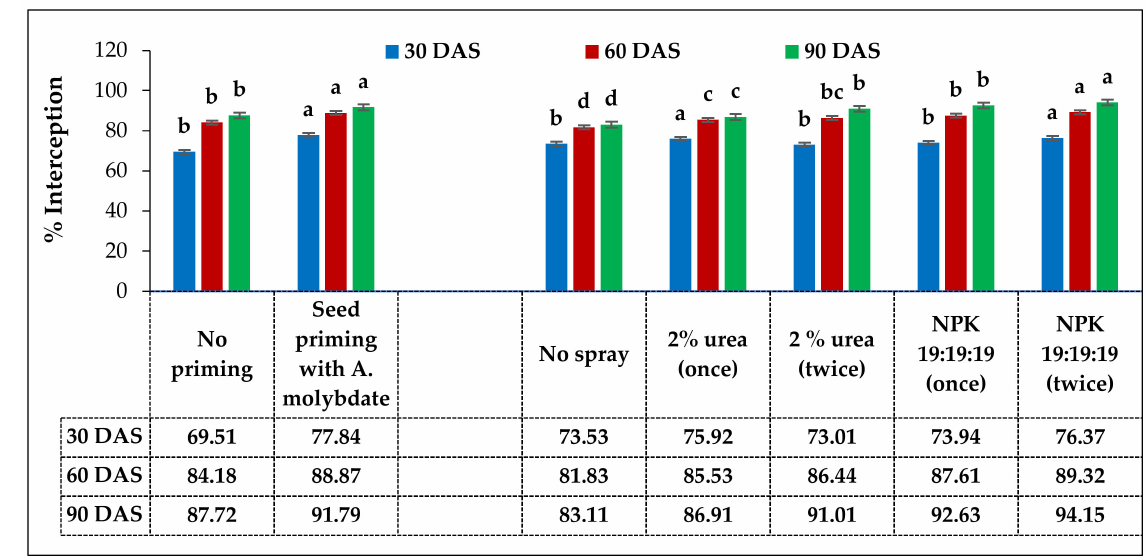
Figure 2. Percent interception of PAR during at different growth stages of grass pea (pooled means of 2 years) (Different letters in all bars indicate the significant differences between means.)